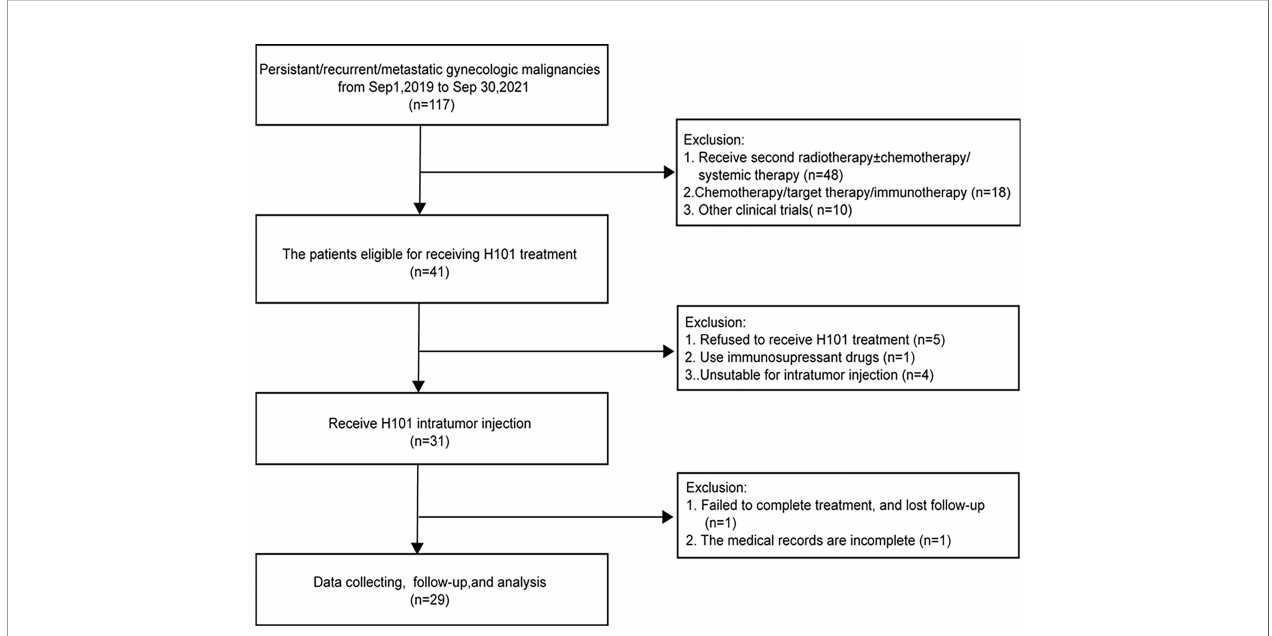
FIGURE 1 | Flow chart of patients entered into the